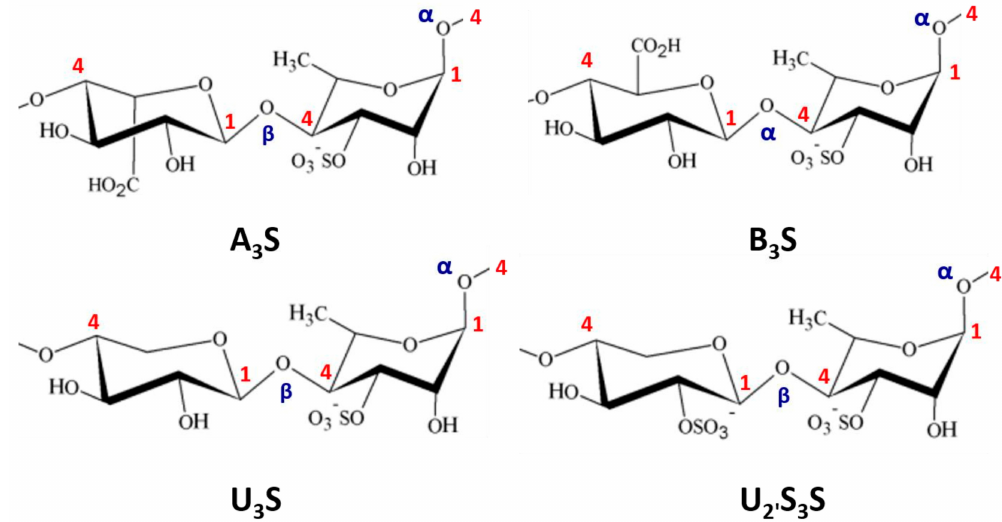
Figure 11. Structures of ulvans. A 3 S : ulvanobiuronate-3-sulfate type A,; B 3 S : ulvanobiuronate-3-sulfate type B; U 3 S : ulvanobiose-3-sulfate type A; U 2’ S 3 S : ulvanobiose-2,3-disulfate type